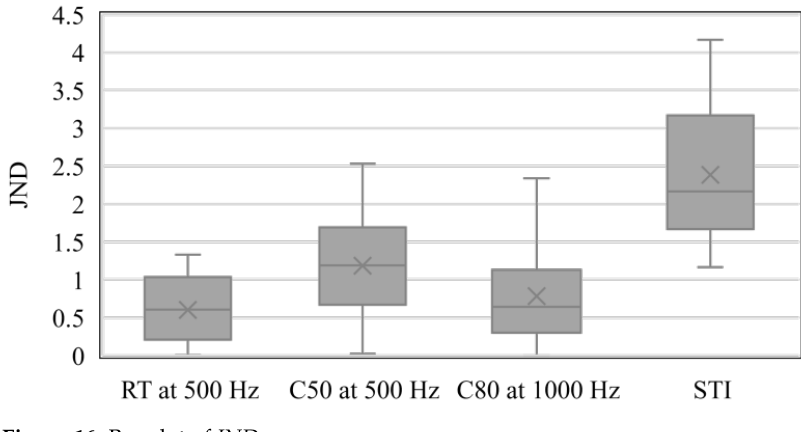
Figure 16. Boxplot of JND . Table 8. The RMSE of each acoustic indicator.